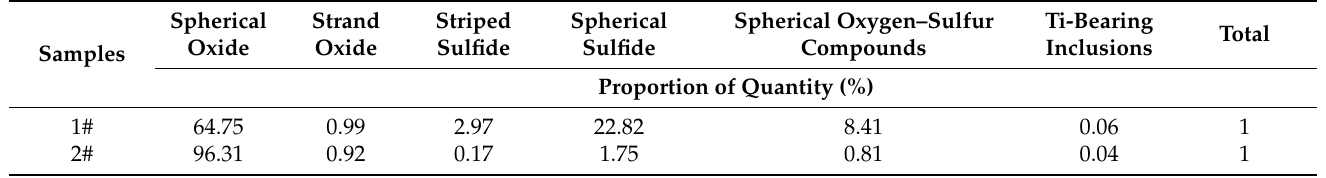
Table 5. The quantities of various inclusions found in 100 mm 2 sections of steel